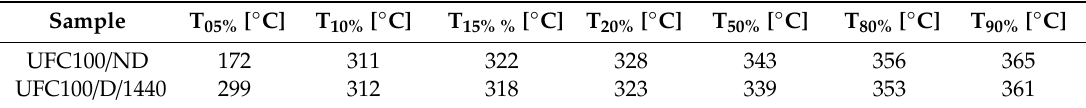
Table 3. Temperatures of the mass loss; T X% —temperature at which the mass loss of x% was detected.